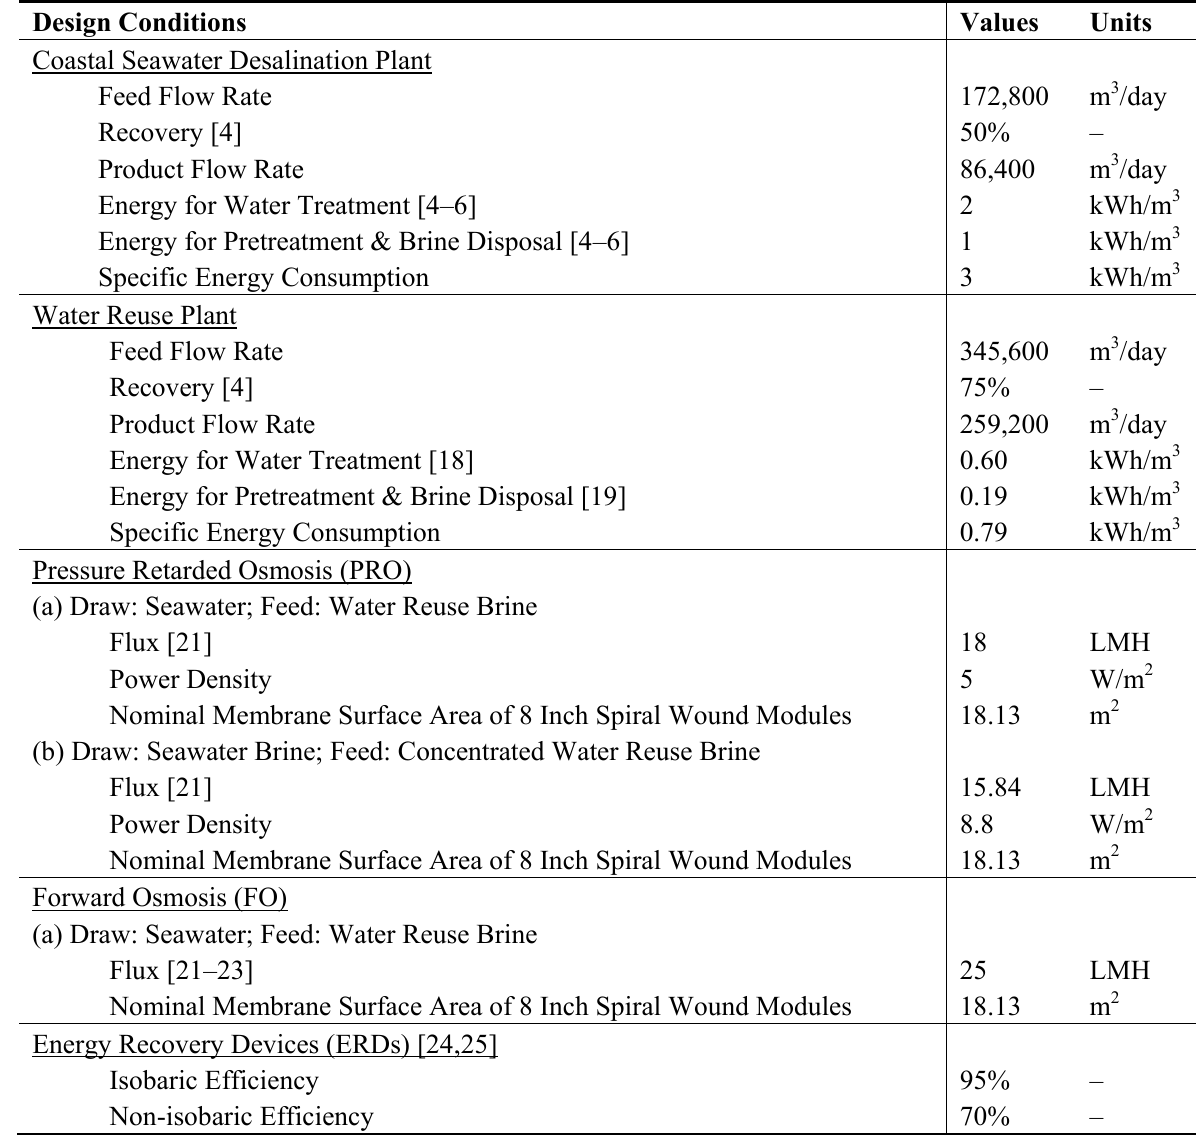
Table 1. Hybrid Process Design